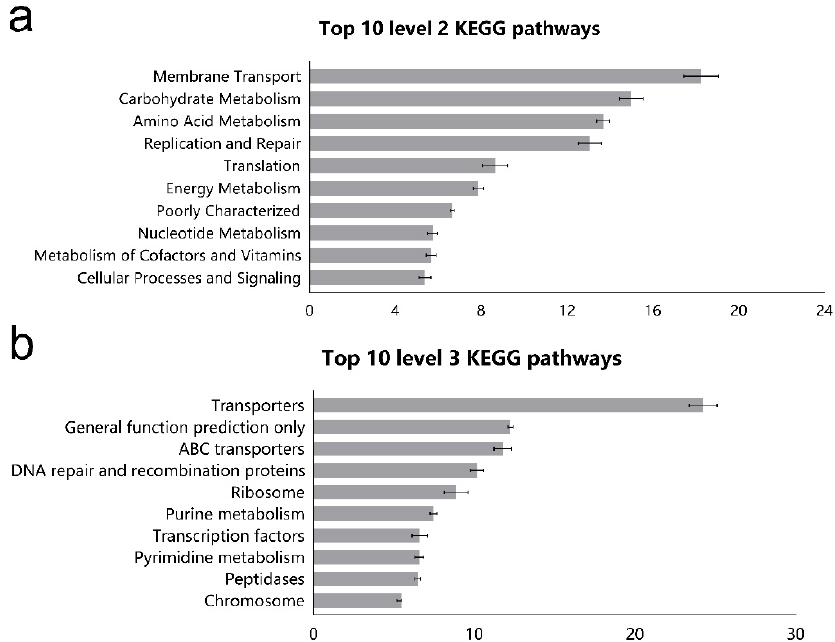
Figure 3. Top 10 predicted metagenomic functions at ( a ) level 2 and ( b ) level 3 of the KEGG (Kyoto Encyclopedia of Genes and Genomes) pathways in ileal bacteria of goats fed the normal and high concentrate diets. The bars stand for the percentage of relative abundance of each predicted function.